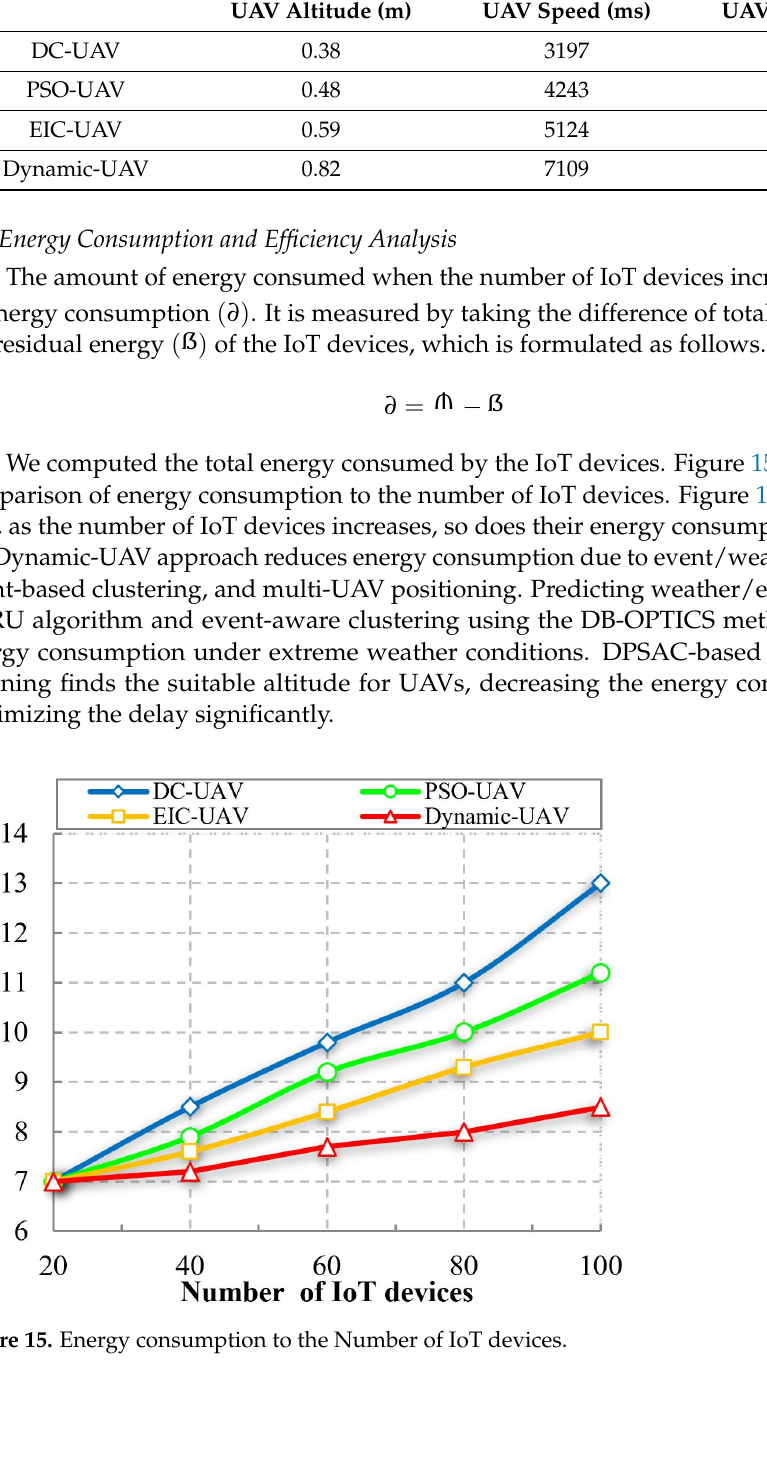
Table 6. Reliability analysis.